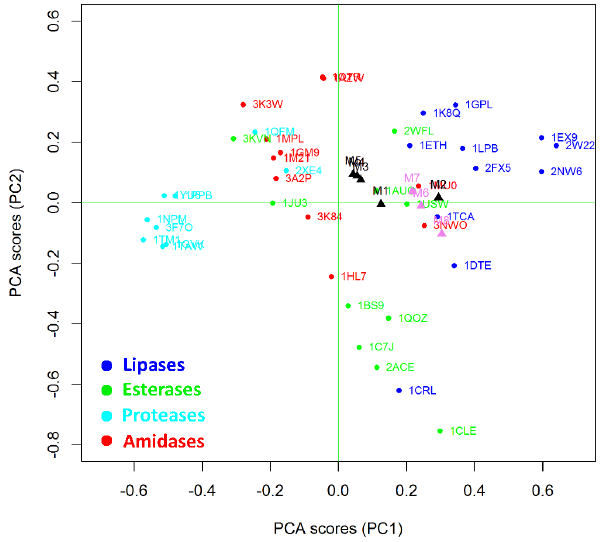
Figure 7. Unsupervised Pattern Cognition Analysis (UPCA) of BioGPS descriptors generated by O probe (H-bond donor capacity). The analyzed enzymes are labelled according to their PDB code and colored as in figure 3. Improved mutants are highlighted in black triangles whereas poor mutants are in pink triangles.